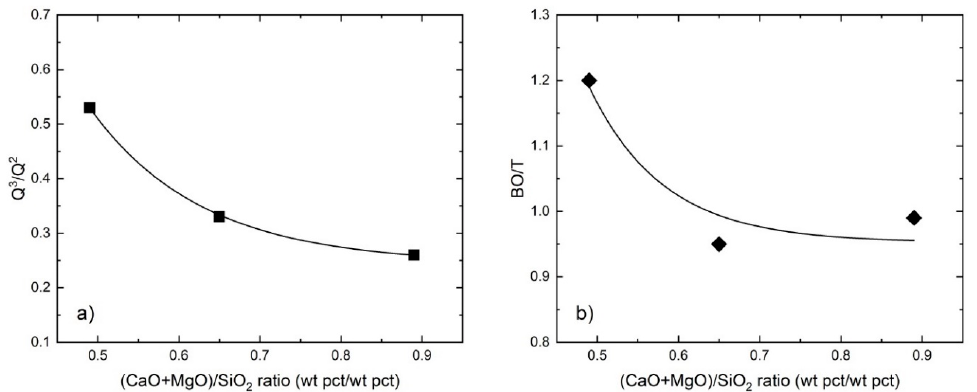
Figure 8. Relationship between basicity and ( a ) Q 3 /Q 2 ratio; and ( b ) bridging oxygen per tetrahedral (BO/T) of FCSM slags ( p O 2 = 10 − 8 atm and T = 1300 °C).